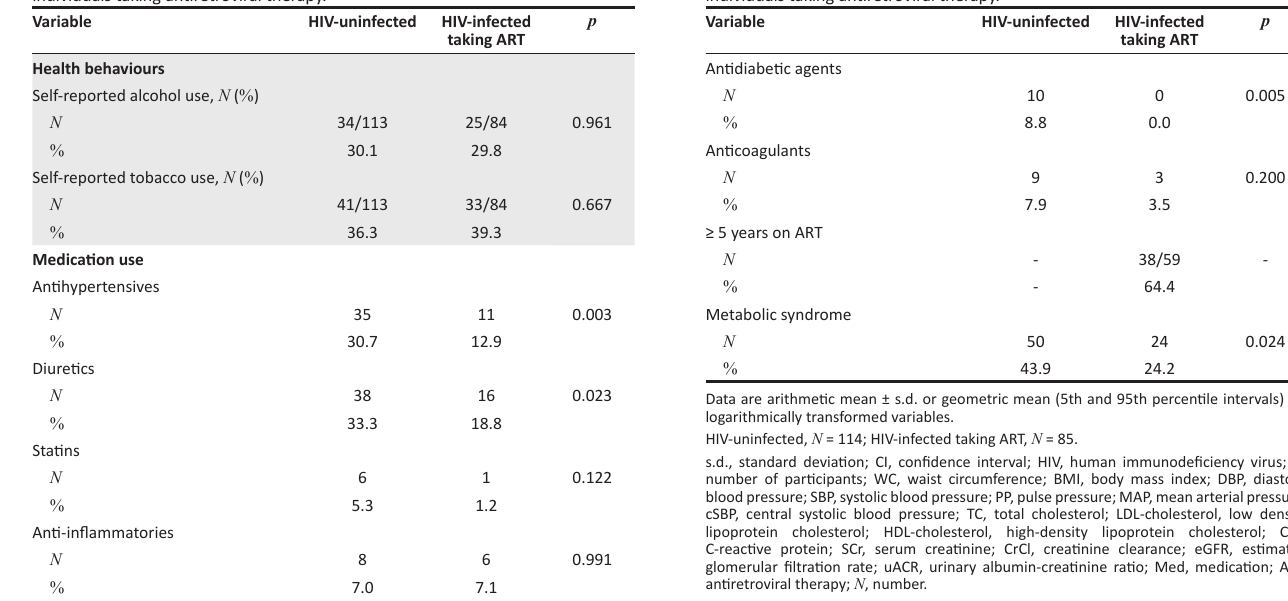
antiretroviral therapy; N ,